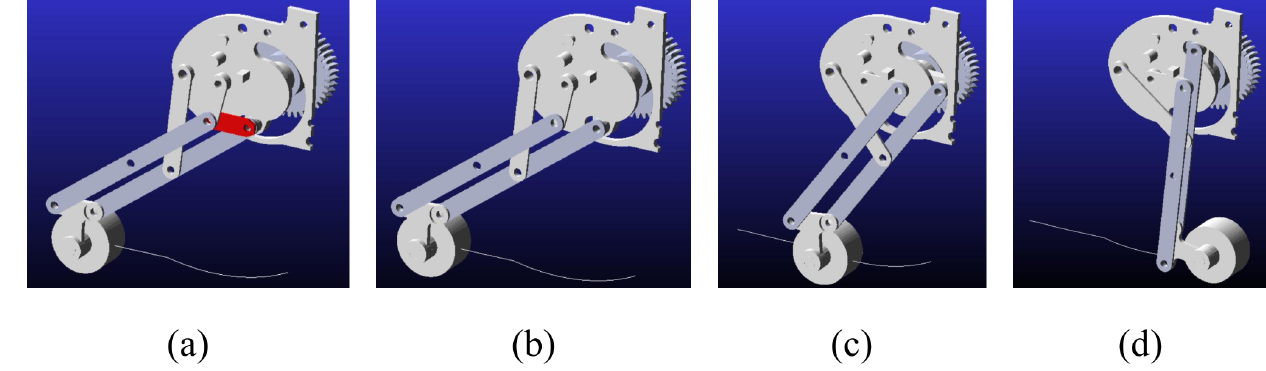
Figure 7. Motion simulation process diagram of the end effector.